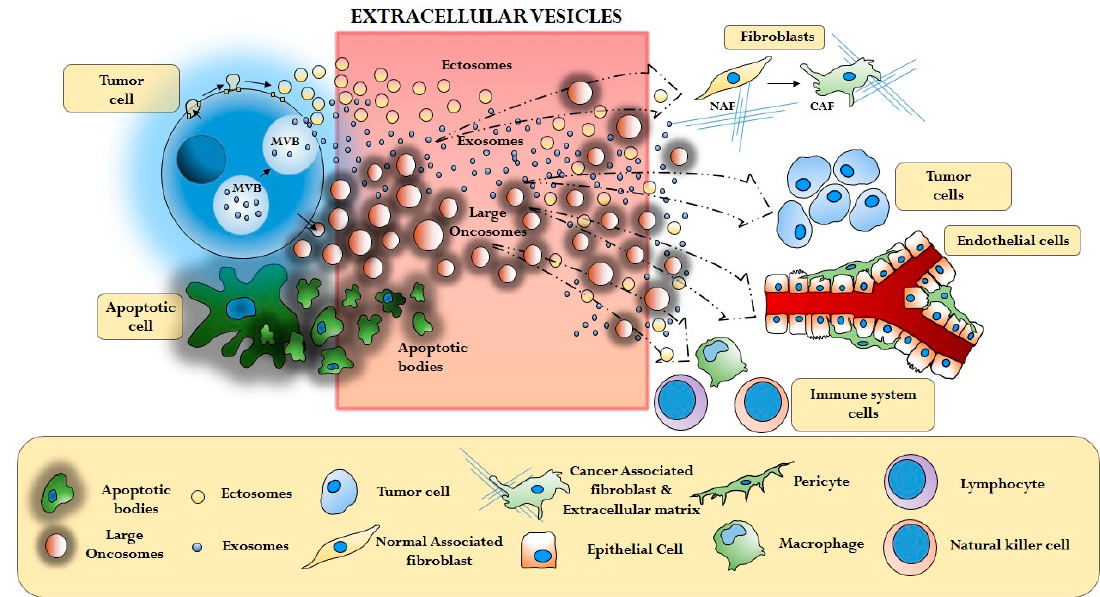
Figure 2. Extracellular Vesicle (EV)-mediated interaction between cancer cells and different components of the tumor microenviroment (Cancer Associated Fibroblasts—CAF, extracellular matrix—ECM, Tumor cells, Endothelial cells, Immune system cells).